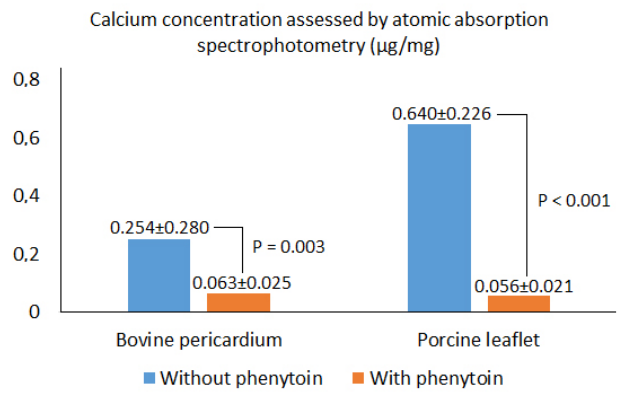
Fig. 8 - Calcium concentrations measured by atomic absorption spectrophotometry in groups of bovine pericardium and porcine leaflets with and without